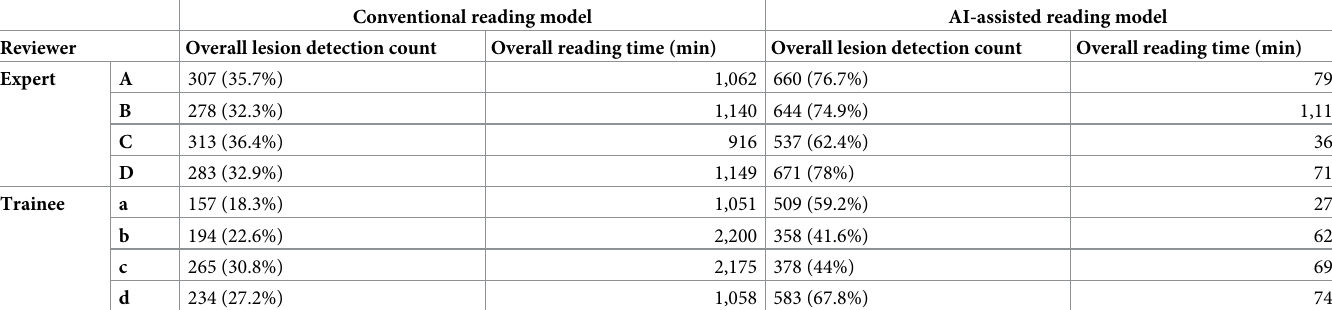
Table 3. Comparison of the lesion detection rates and reading times of reviewers between the reading models.